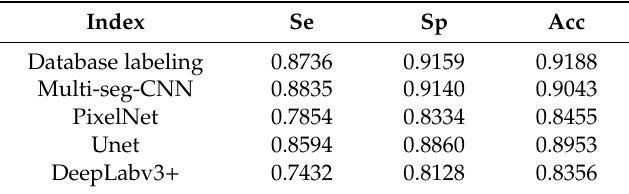
Table 5. Roth spots segmentation accuracy by di ff erent